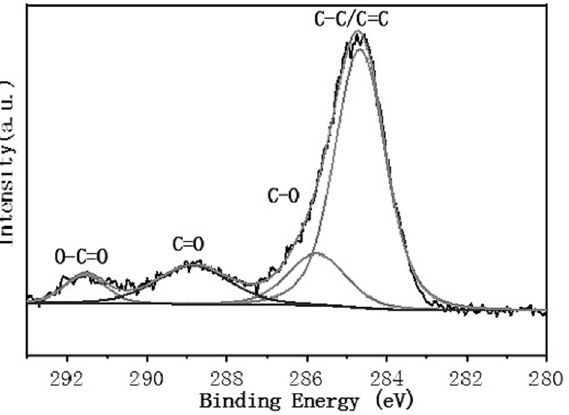
Figure 11. The C 1s spectrum: four peaks with binding energies of 284.5 eV, 286.6 eV and 288.7 eV, 291.5 eV.